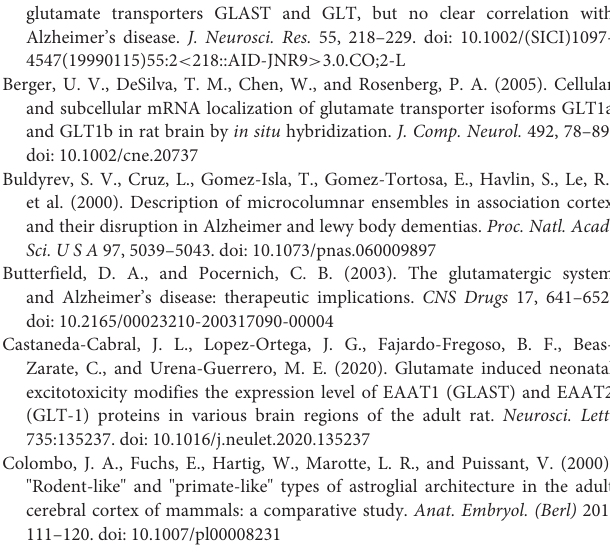
SUPPLEMENTARY FIGURE 1 | Western blot against human hippocampus homogenates probed with EAAT2 antibody (A) . The omission of the primary antibodies (B) resulted in a complete absence of immunoreactivity except for a small amount of background lipofuscin staining (B,c) . The section was